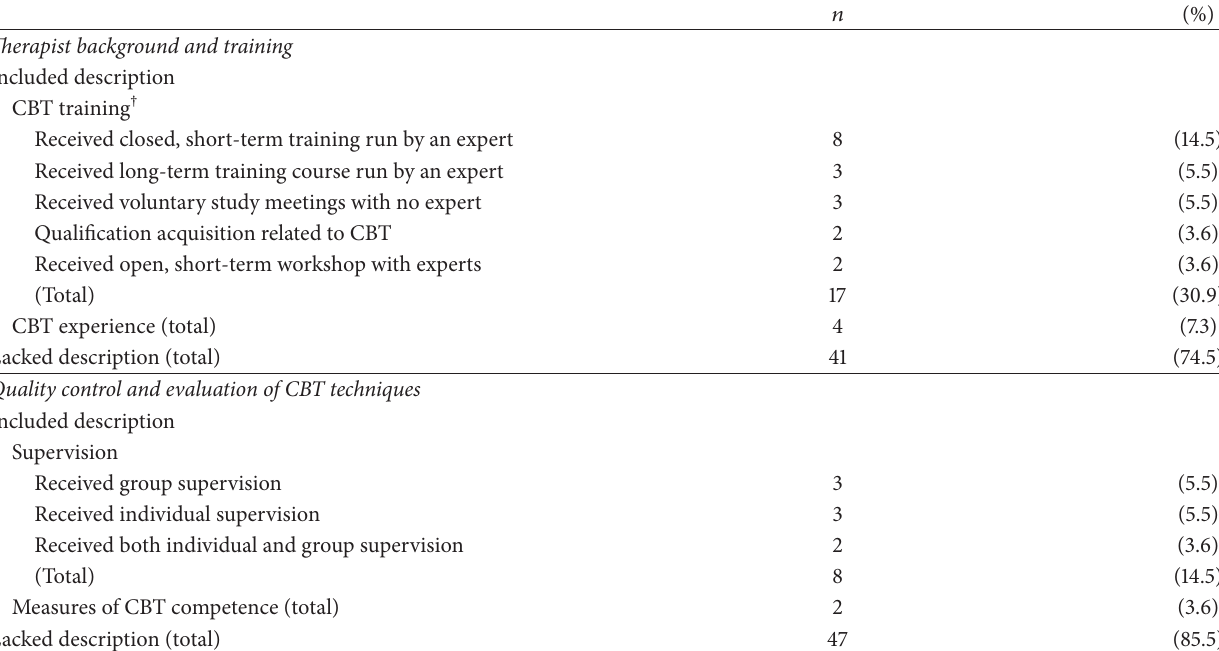
Table 3: Reporting on quality of cognitive behavioral therapy ( 𝑛 = 55